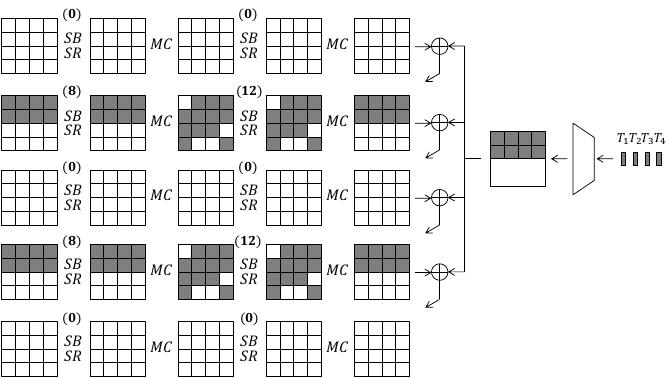
Figure 3: TweAES : An Example of the Differential Trail with 40 Active